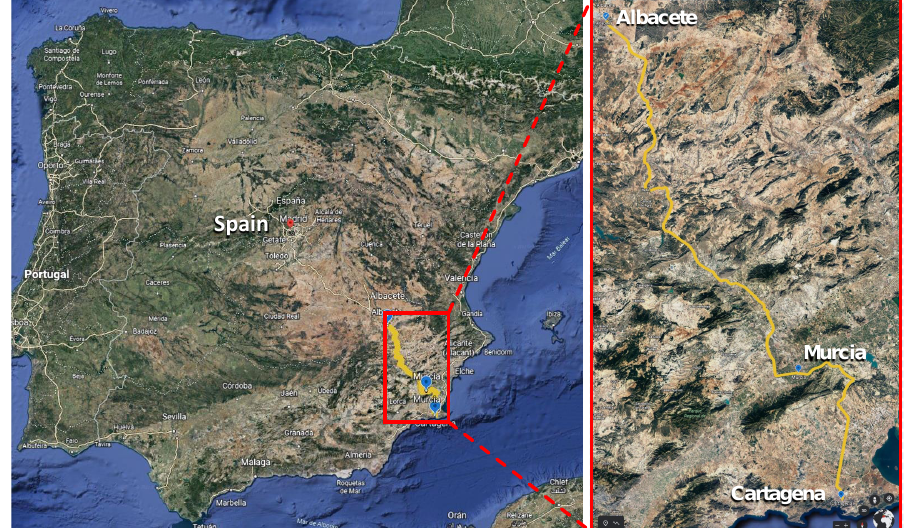
Figure 7. Albacete–Cartagena route traced in Google Earth.